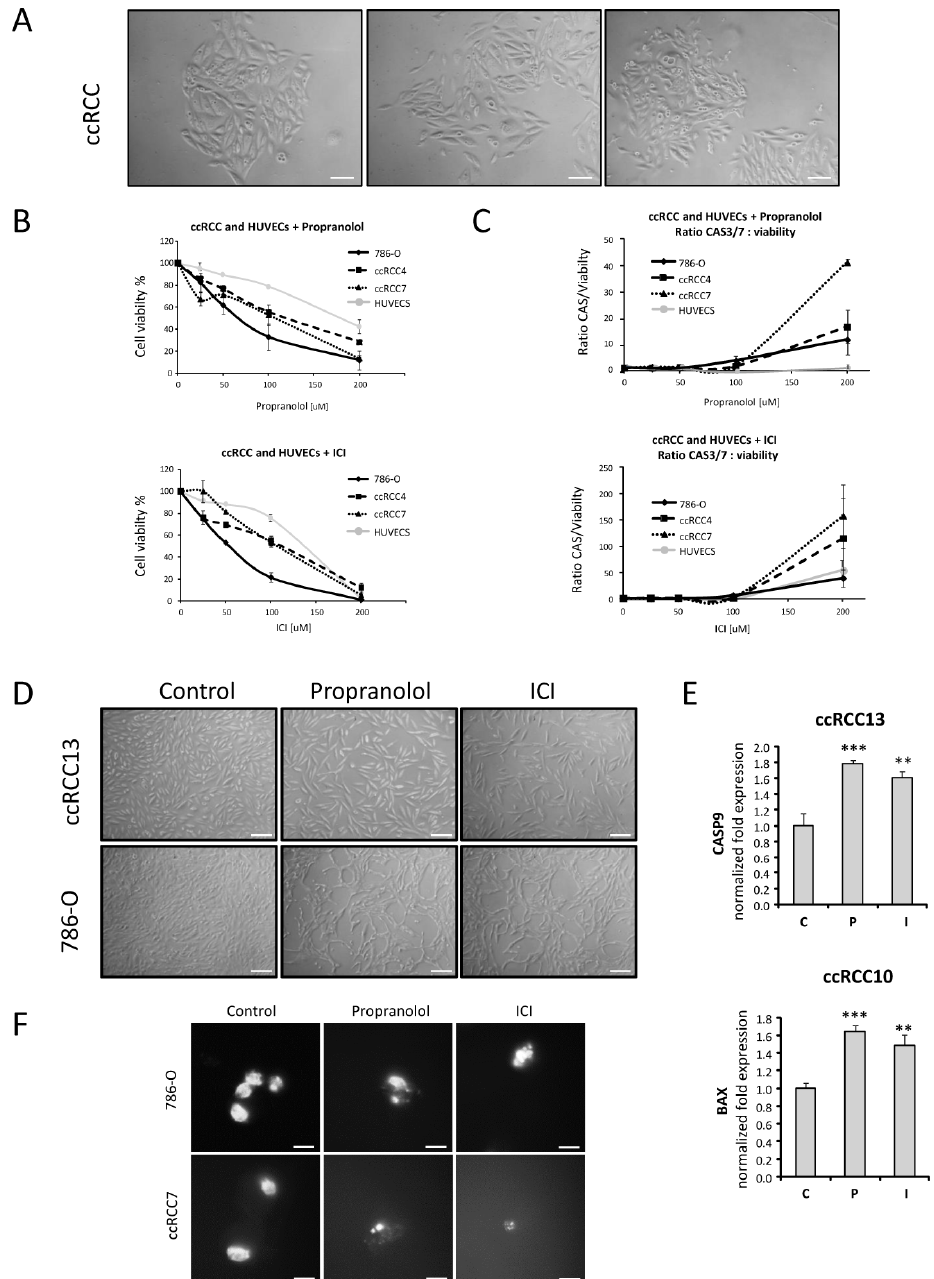
Figure 1. Effect of β 2-adrenergic receptor (ADRB) blockers on cell viability of VHL − / − and VHL +/+ cells. ( A ). Representative images of a primary clear cell renal cell carcinoma (ccRCC) tumor culture derived from a VHL patient. ( B , C ). Effect of β 1 and β 2-adrenergic receptor blockage in cell viability and Caspases 3/7 activation after propranolol and ICI-118,551 (ICI) incubation on VHL − / − ccRCC cells such as 786-O, ccRCC4, and ccRCC7 and on the VHL +/+ endothelial primary cells HUVECs. Cultures were treated with increasing doses [0–200 µM] propranolol or ICI for 72 h. ( D ). Representative images of ccRCC13 and 786-O cultures treated with 100 µM propranolol or ICI for 72 h. ( E ). mRNA quantification of the apoptotic genes CASP9 and BAX on ccRCC primary tumors treated with 100 µM propranolol or ICI for 72 h. ( F ). Propranolol and ICI cause chromatin condensation induced by cellular apoptosis. All data are based on 3 independent experiments. Scale bars represent 100 µm ( A , D ) and 50 µm ( F ). Abbreviations: C, P, and I for control, propranolol, and ICI, respectively. Error bars denote ± SEM. Student’s t -test: * p < 0.05; ** p < 0.01; *** p < 0.001.